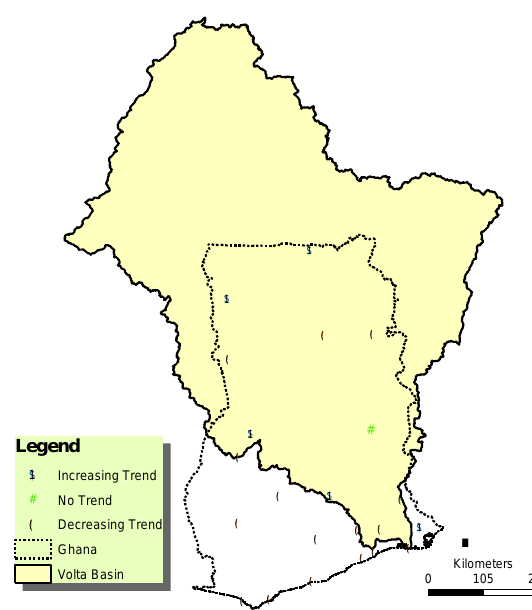
Figure 3. Spatial distribution of the rainfall trends.